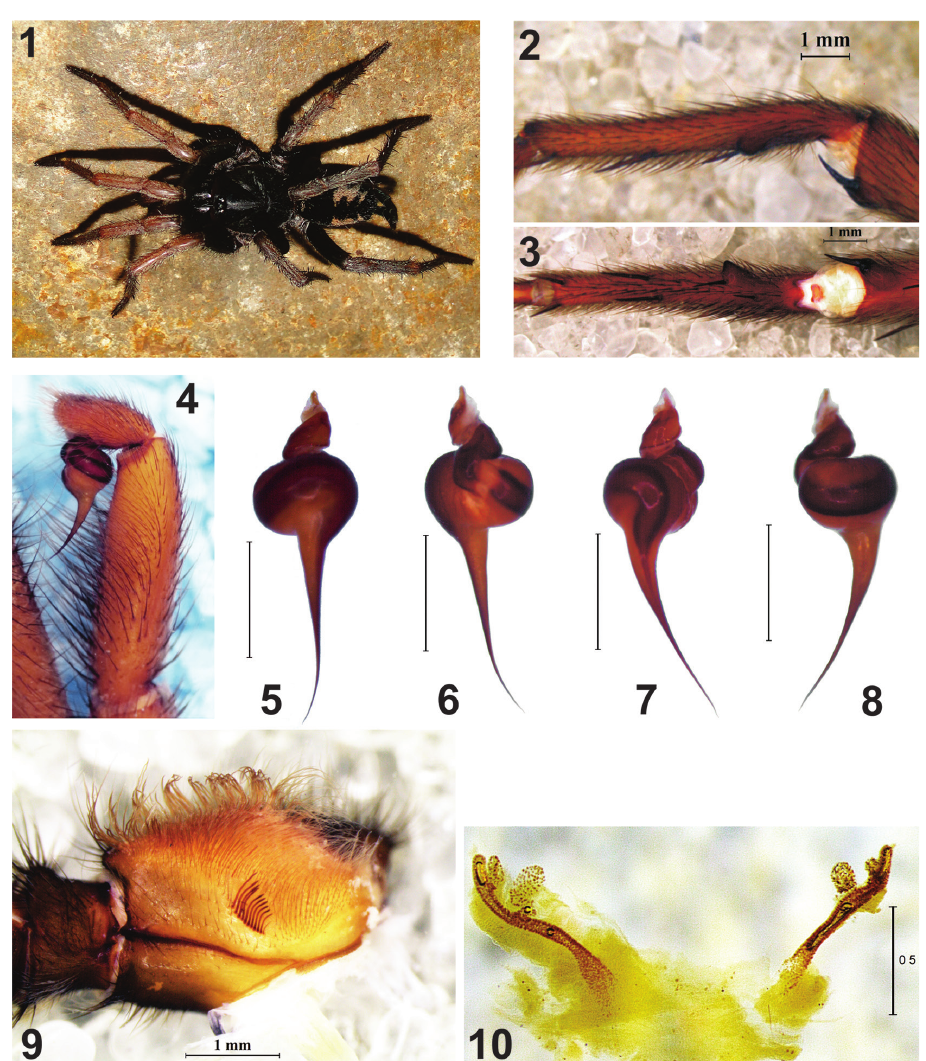
Figures 1–10. Diplura mapinguari sp. n. Juvenile: 1 habitus dorsal (Porto Velho-RO, photo R. Indicat- ti). Male: left leg I 2 tibial spur, retrolateral 3 tibial spur and metatarsal clasper, ventral 4 left palp, retro- lateral; left bulb 5 retrolateral 6 prolateral 7 ventral 8 dorsal 9 maxilla with lyra. Female: 10 receptaculum seminis